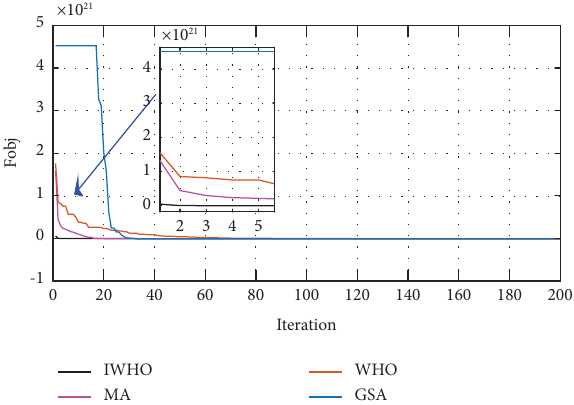
Figure 7: Convergence characteristic of proposed algorithms.